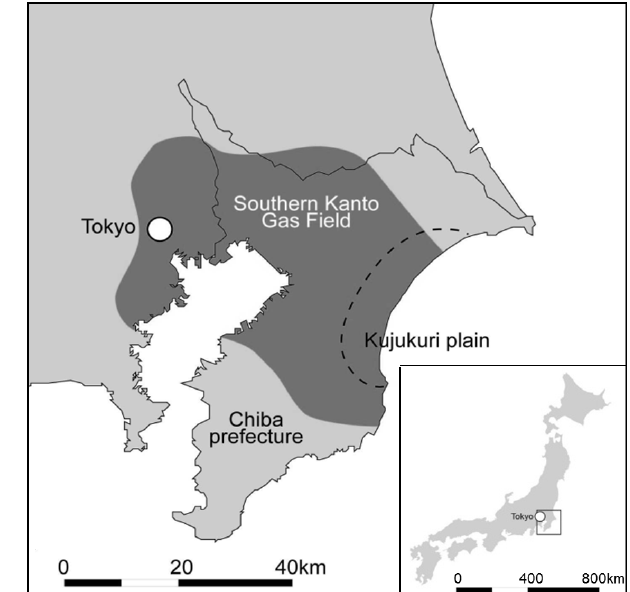
Figure 1. The Southern Kanto gas field.